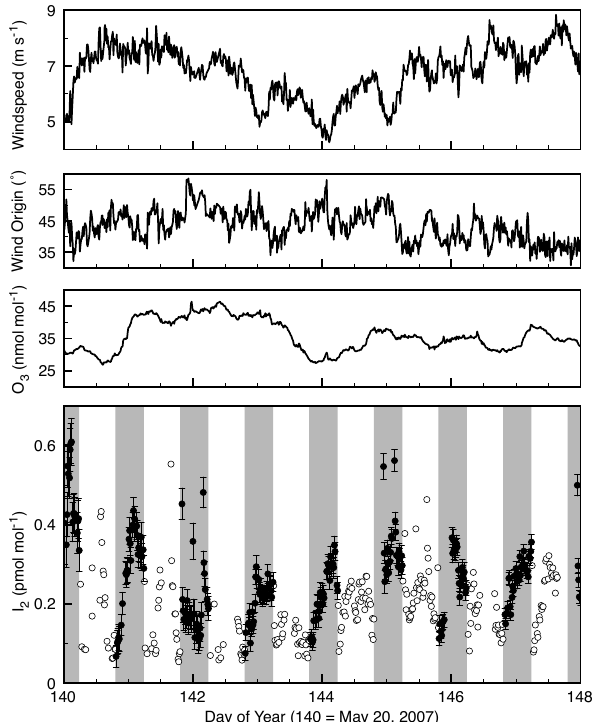
Fig. 2. Wind speed, wind direction, O 3 mixing ratios, and I 2 mixing ratios at CVAO during May 2007 time at CVAO. I 2 error bars are one standard error. Open circles are daytime points which likely in- clude a measurement artifact and should be considered upper limits. The dark vertical bars represent nighttime